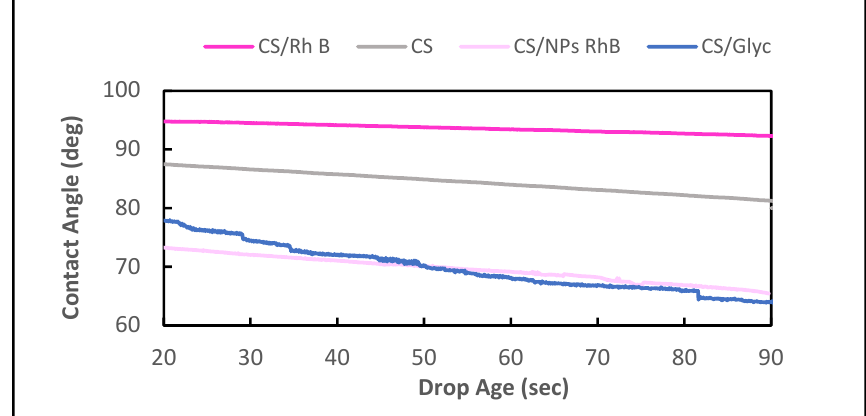
Figure 5. Effect of the ageing time on the wettability of different chitosan films. The initial contact angle is a measure of the membrane surface wetting with water. A